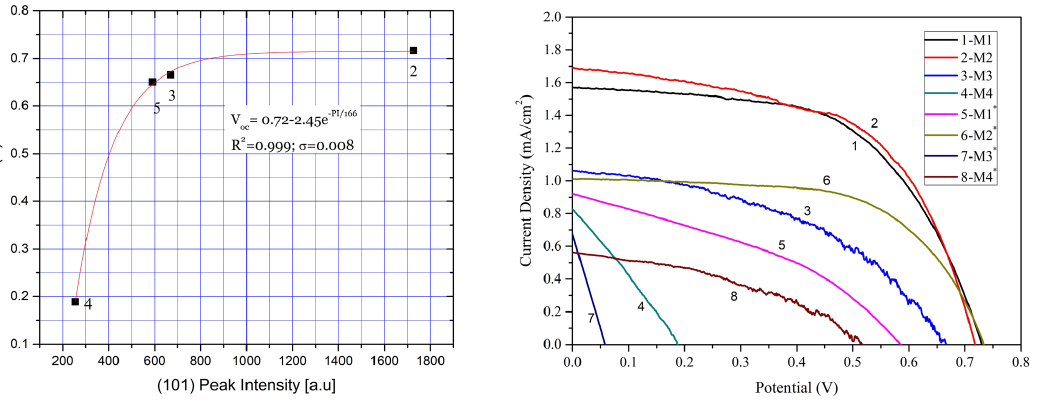
Figure 11. Current-voltage plot of the studied